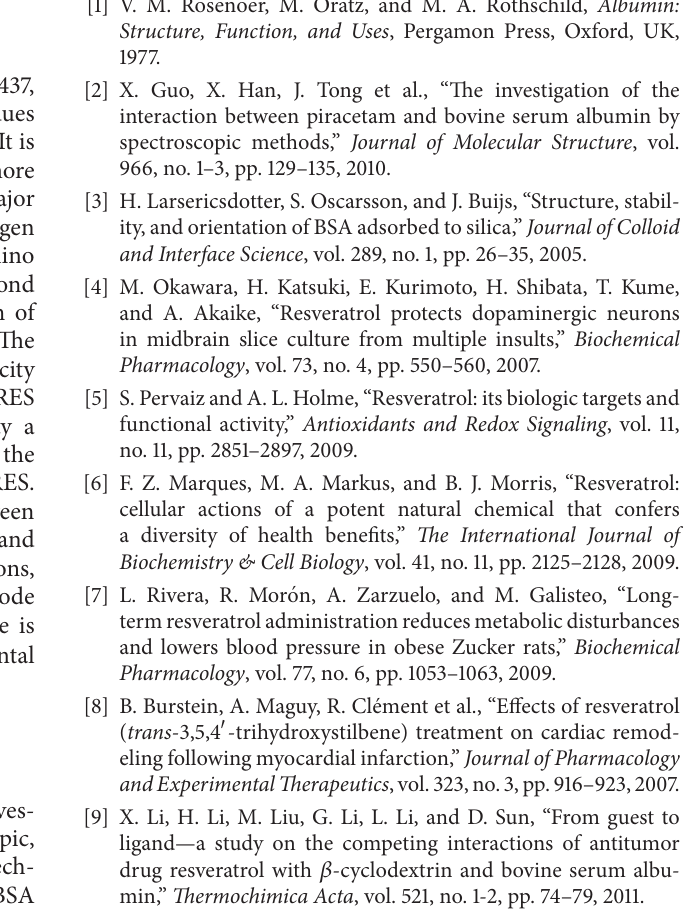
Figure 8: The amino acid residues around TRES within 6 ˚A. The residues of BAS are represented using line, TRES structure is represented using stick, and the hydrogen bonds are represented using green dashed